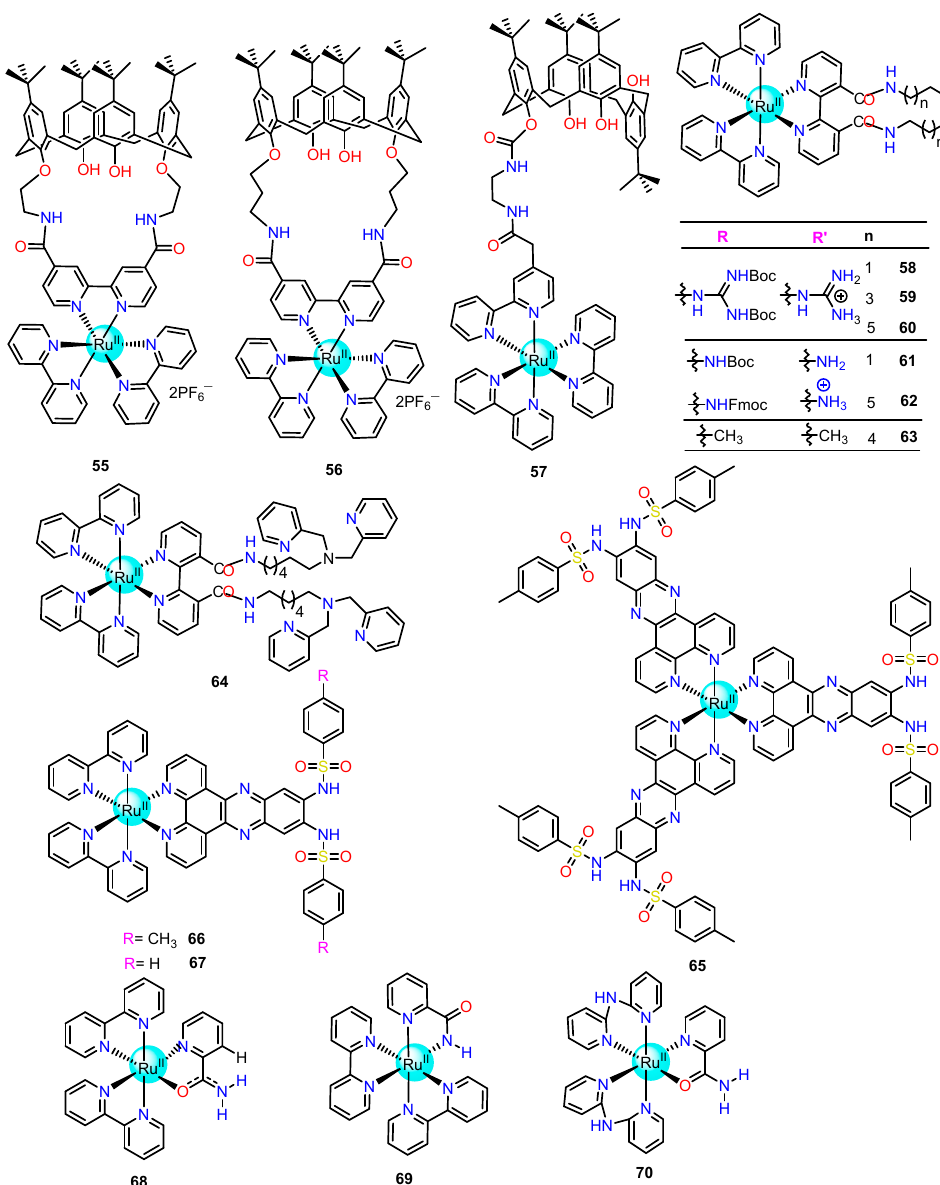
Figure 9. Structures of Amide/Sulphonamide/Picolinamide-based Ru(II) complexes 55 – 70.